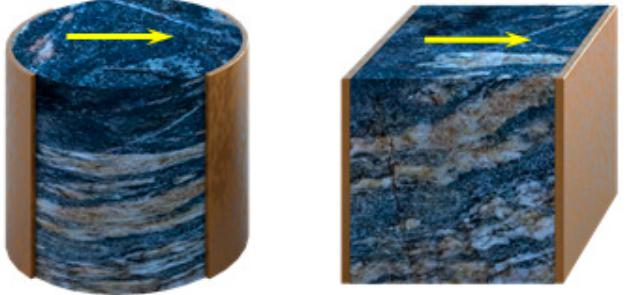
Figure 2. Current direction simulated using radial resistivity testing method. Based on the radial resistivity testing method proposed by Jianhuan He (2020 [36]), electrode per unit time under the known potential difference.